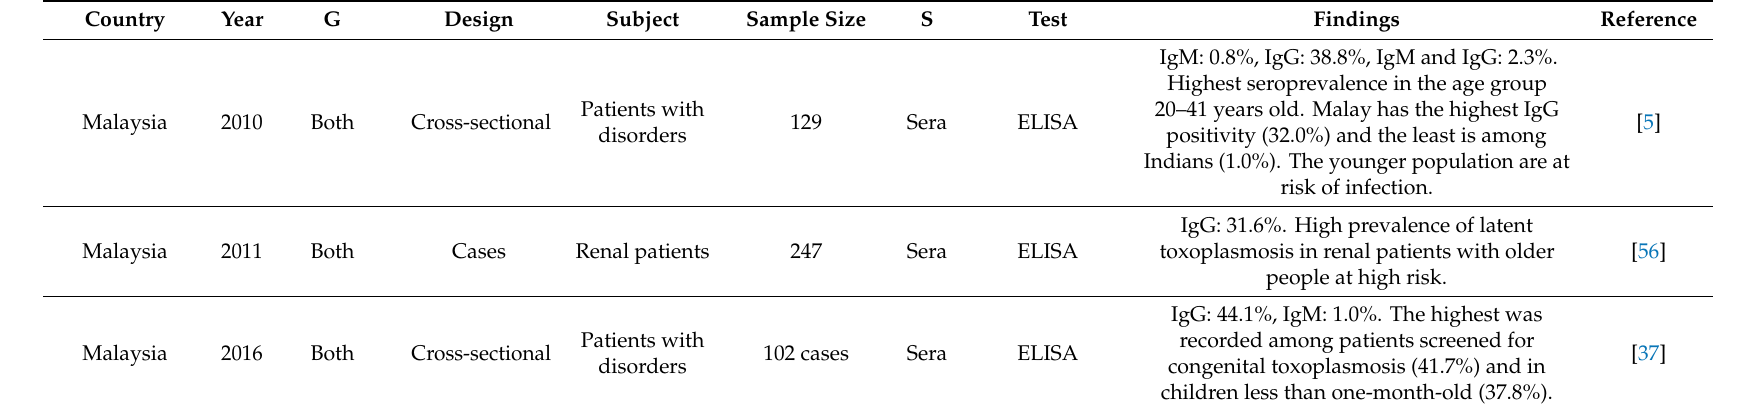
Table 3. Serological prevalence of toxoplasmosis among patients presenting with various disorders in Malaysia.